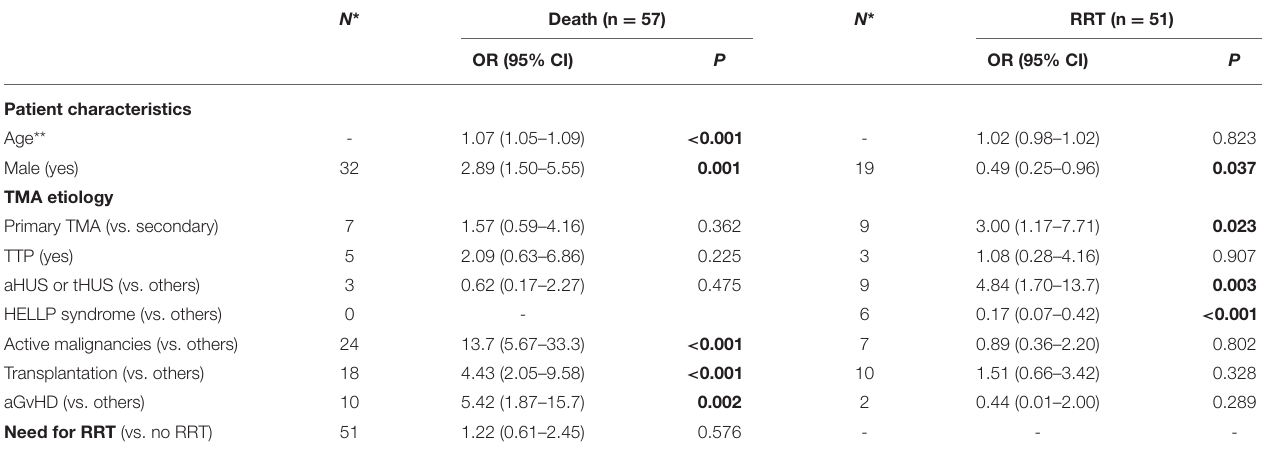
TABLE 4 | Univariate analysis of factors associated with